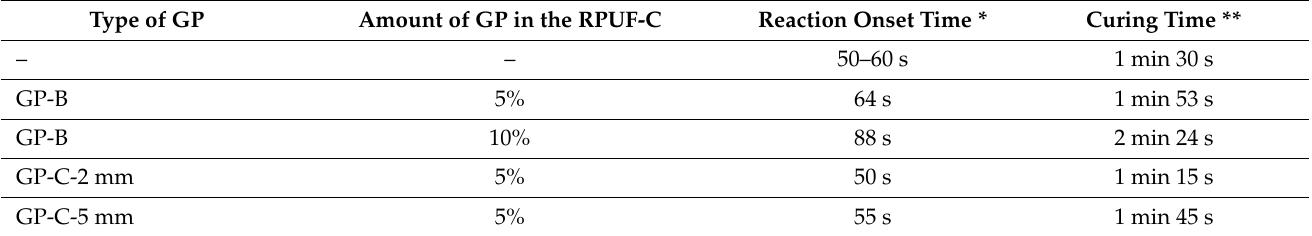
Table 6. Results of the reaction onset and curing time of GPs in the RPUF-C formulations. Type of GP Amount of GP in the RPUF-C Reaction Onset Time * Curing Time